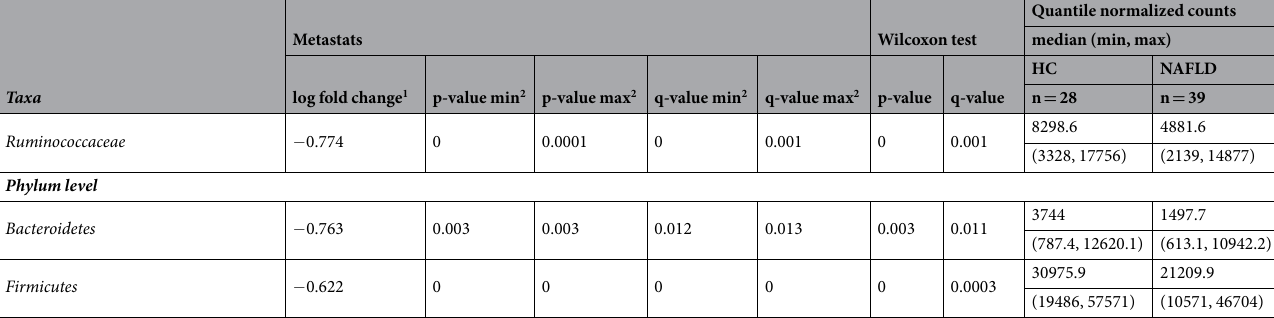
Table 2. Taxa identified as differentially abundant in patients with NAFLD (SS or NASH) compared to HC by Metastats and Wilcoxon rank sum test. 1 Negative parameter denotes that taxon is more abundant in HC, positive – that it is more abundant in NAFLD. 2 Estimated in 3 rounds of permutations, 10,000 instances each. HC: healthy